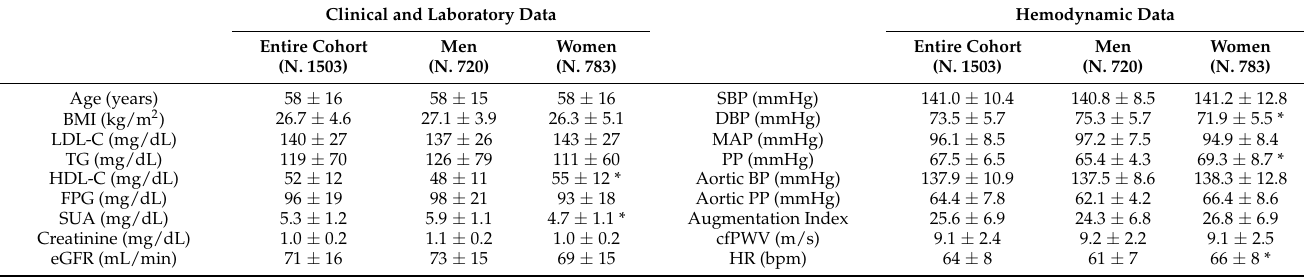
Table 1. Main clinical and laboratory characteristics of the entire study population and by sex.